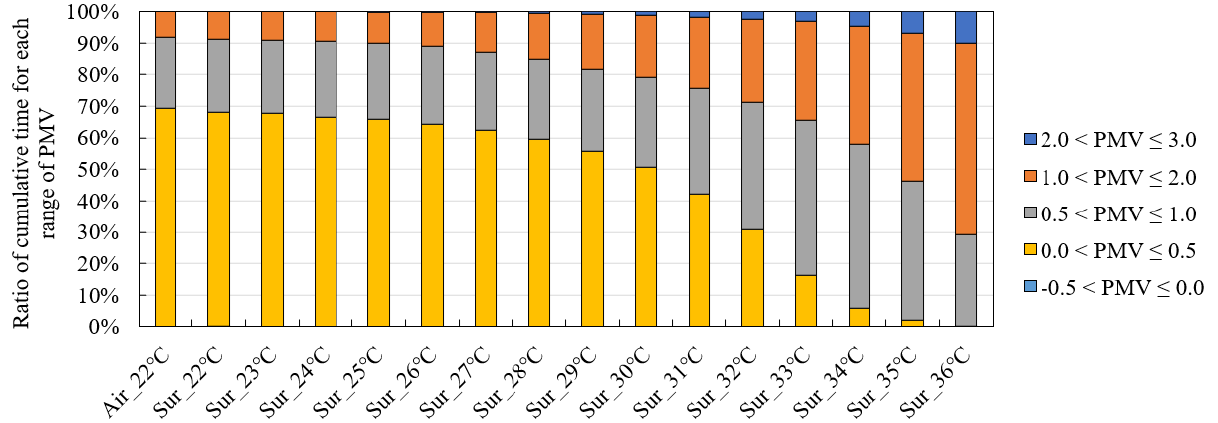
Figure 17. Ratio of cumulative time for each range of PMV for the glass zone.